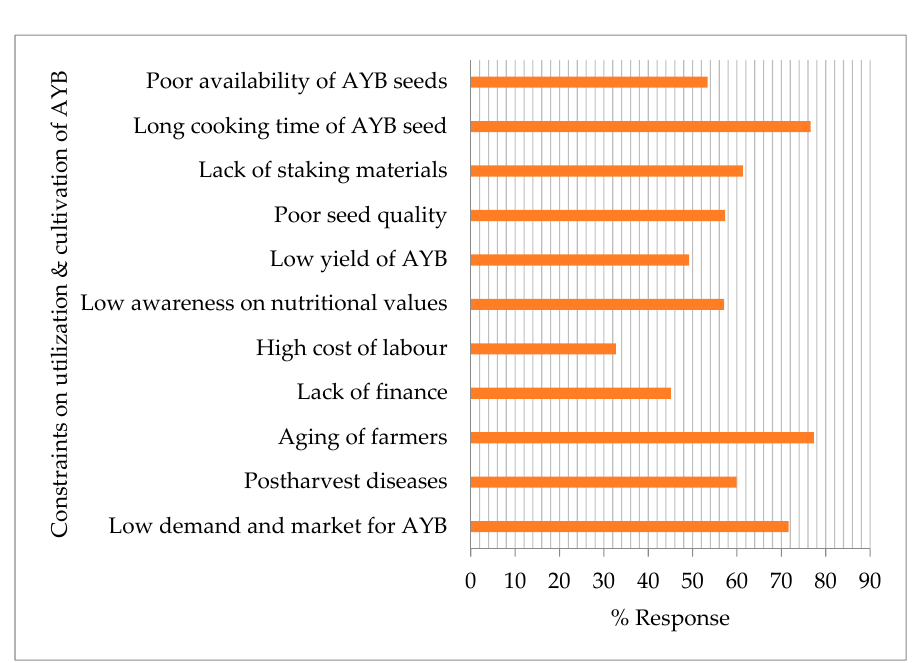
Figure 8. Constraints on the utilization and cultivation of AYB in southeastern Nigeria as determined by data from the 2016 field survey.